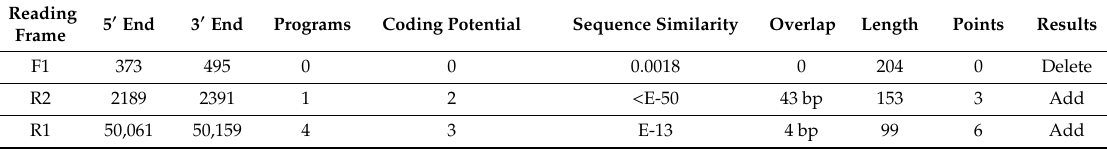
Table 6. Typical entries for putative genes with evaluation